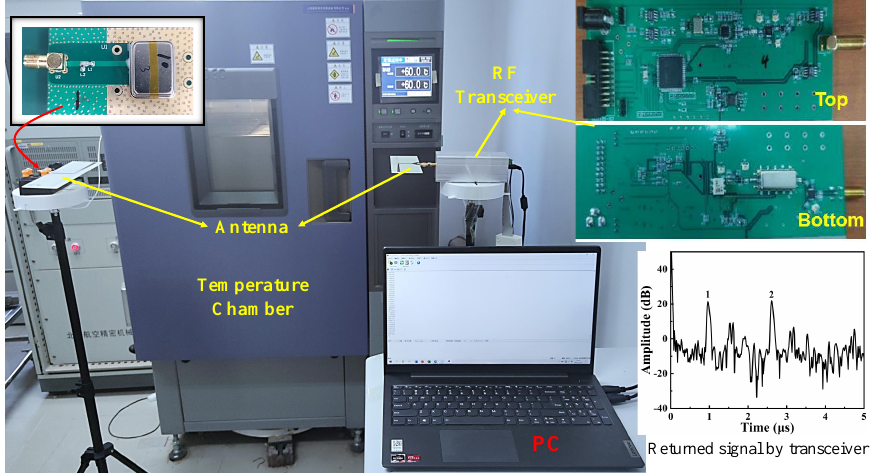
Figure 3. The wireless system and corresponding setup for temperature